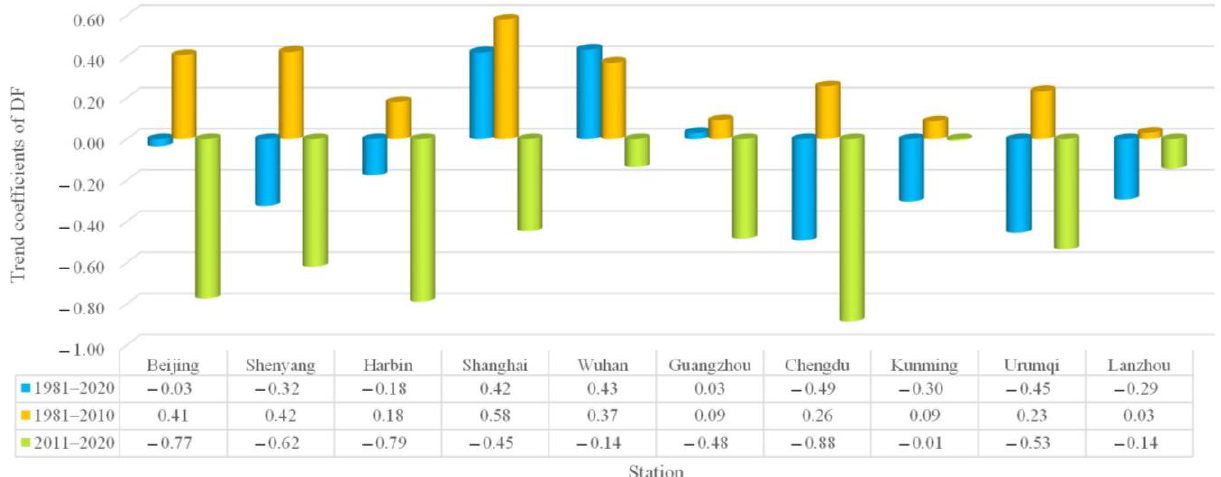
Figure 5. Trend coefficients of DF from 1981 to 2020 for the ten selected stations.